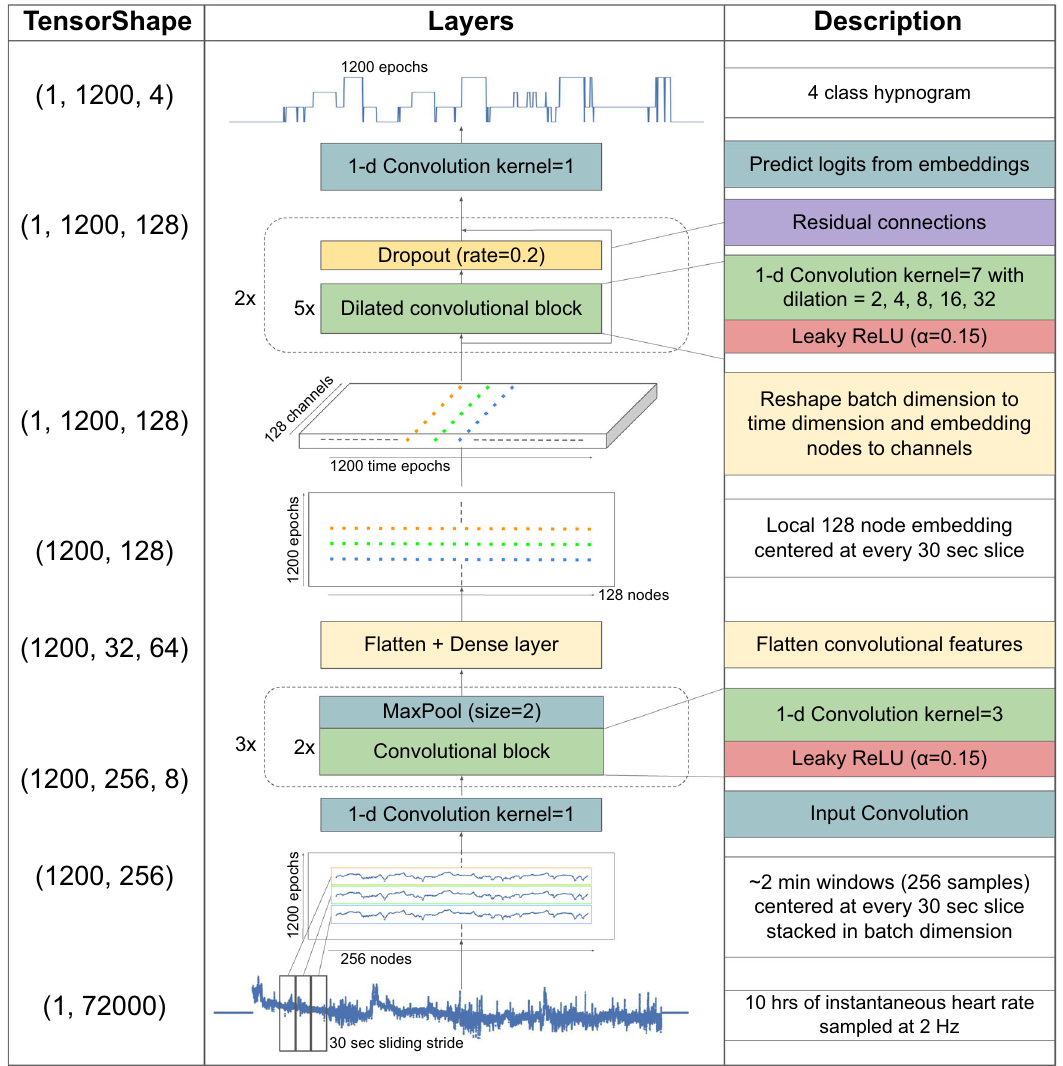
Fig. 1 Neural network architecture for sleep stage classi fi cation. Instantaneous heart rate, resampled to 2 Hz and padded to 72000 samples (10 h) is used as input. 1200 overlapping patches containing 256 samples each are created, one for every 30 s epoch of the input. Convolutional layers are used to extract local features from each patch to an 128-node embedding layer. The local features are then concatenated to form a vector time-series of length 1200 and depth 128. Next, dilated convolutional layers are used to extract long range temporal features across the length of the vector. Finally, an output convolutional layer is used to output 1200 four-class probability